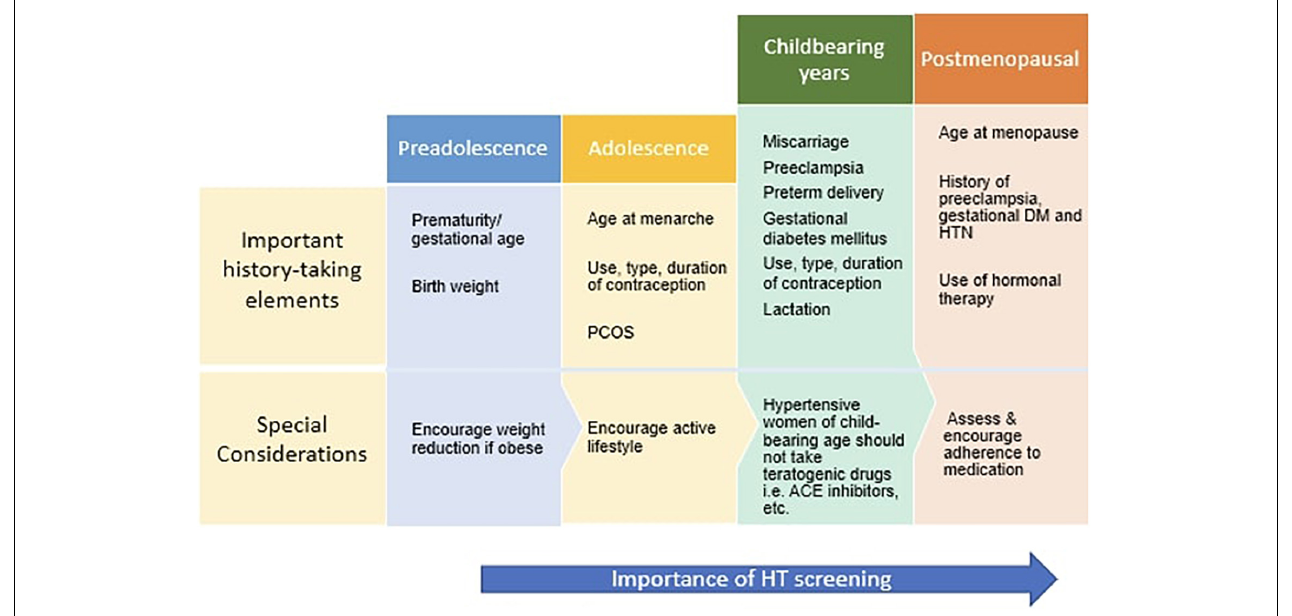
FIGURE 3 | Considerations along the life cycle of a